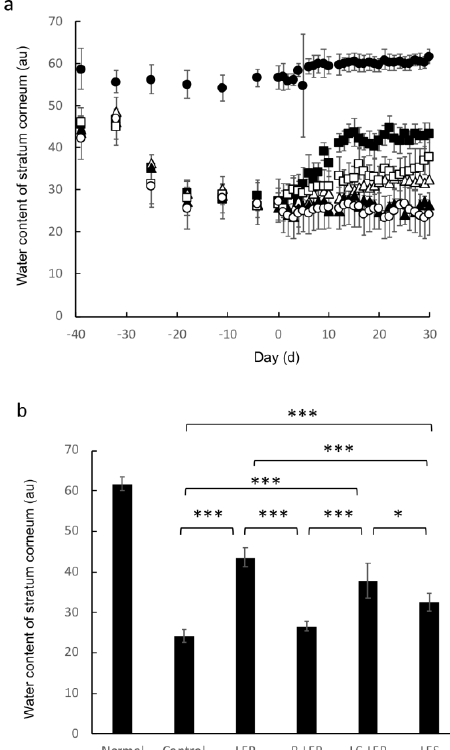
Figure 3. Water content of the stratum corneum of regular and HR-AD-fed mice after oral administration of lactic acid bacteria metabolites over time ( a ), and after 40 days ( b ). Data represent mean and standard deviation ( n = 4 to 6). * p < 0.05, *** p < 0.001 ( Tukey’s post-hoc test). Symbols: closed circle, normal (regular diet fed, distilled water); open circle, control (HR-AD fed, 10.8% ethanol in water); closed square, lactic fermentation products (HR-AD fed, LFP); closed triangle, residue of LFP (HR-AD fed, LFP); open square, lipid components of LFP (HR-AD fed, LC-LFP); open triangle, lactic fermentation secretion (HR-AD fed, LFS).